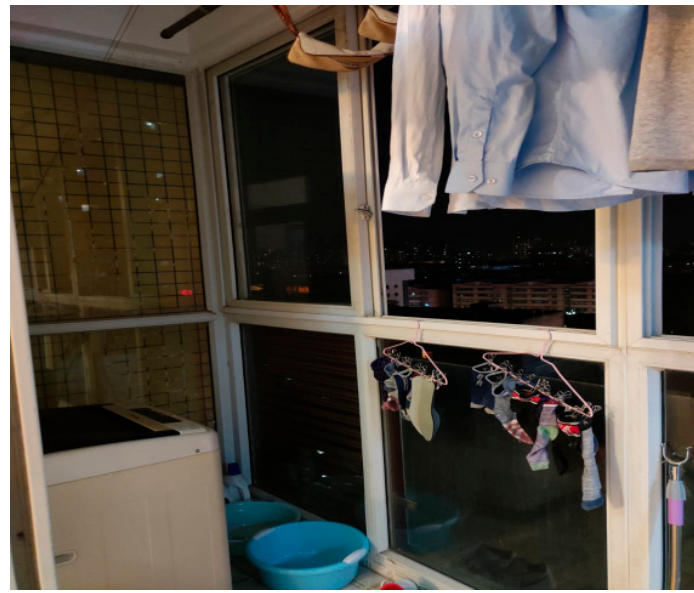
Figure 4. Ventilation opening of the balcony.